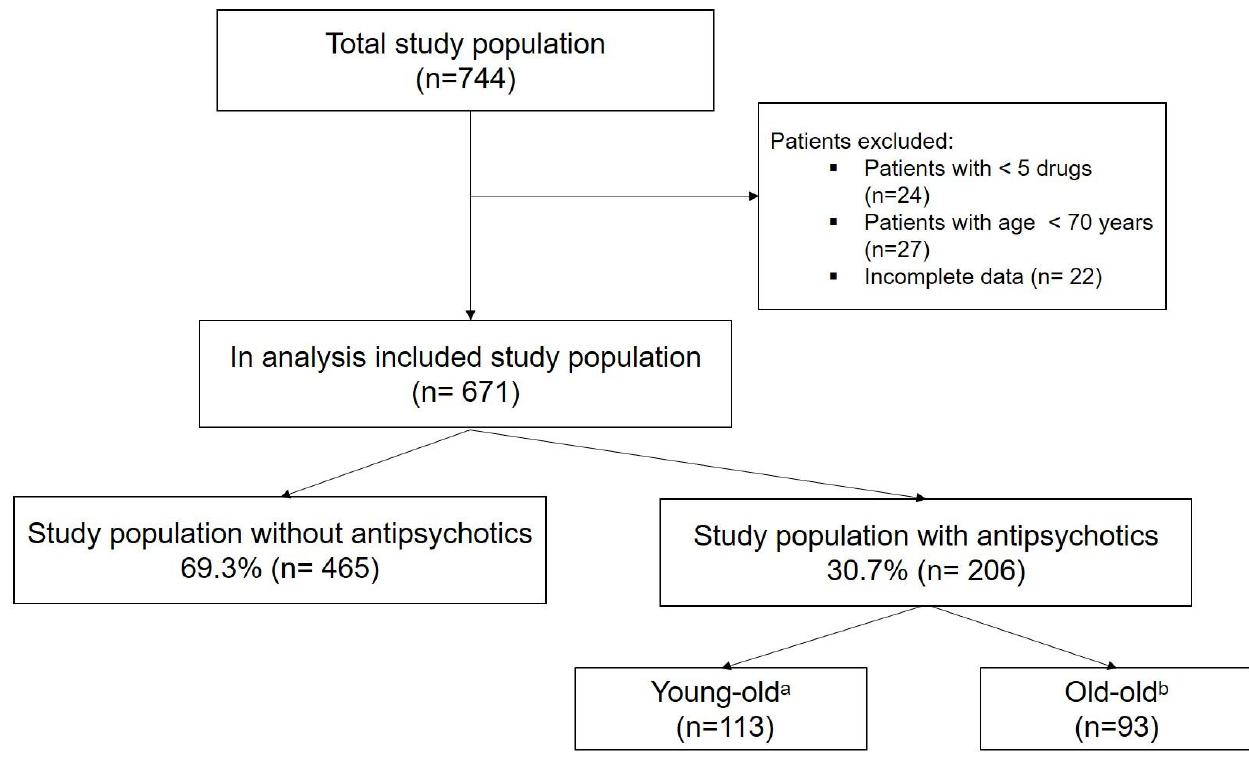
Figure 1. Study population. a 70 – 84 years. b 85 – 100 years.